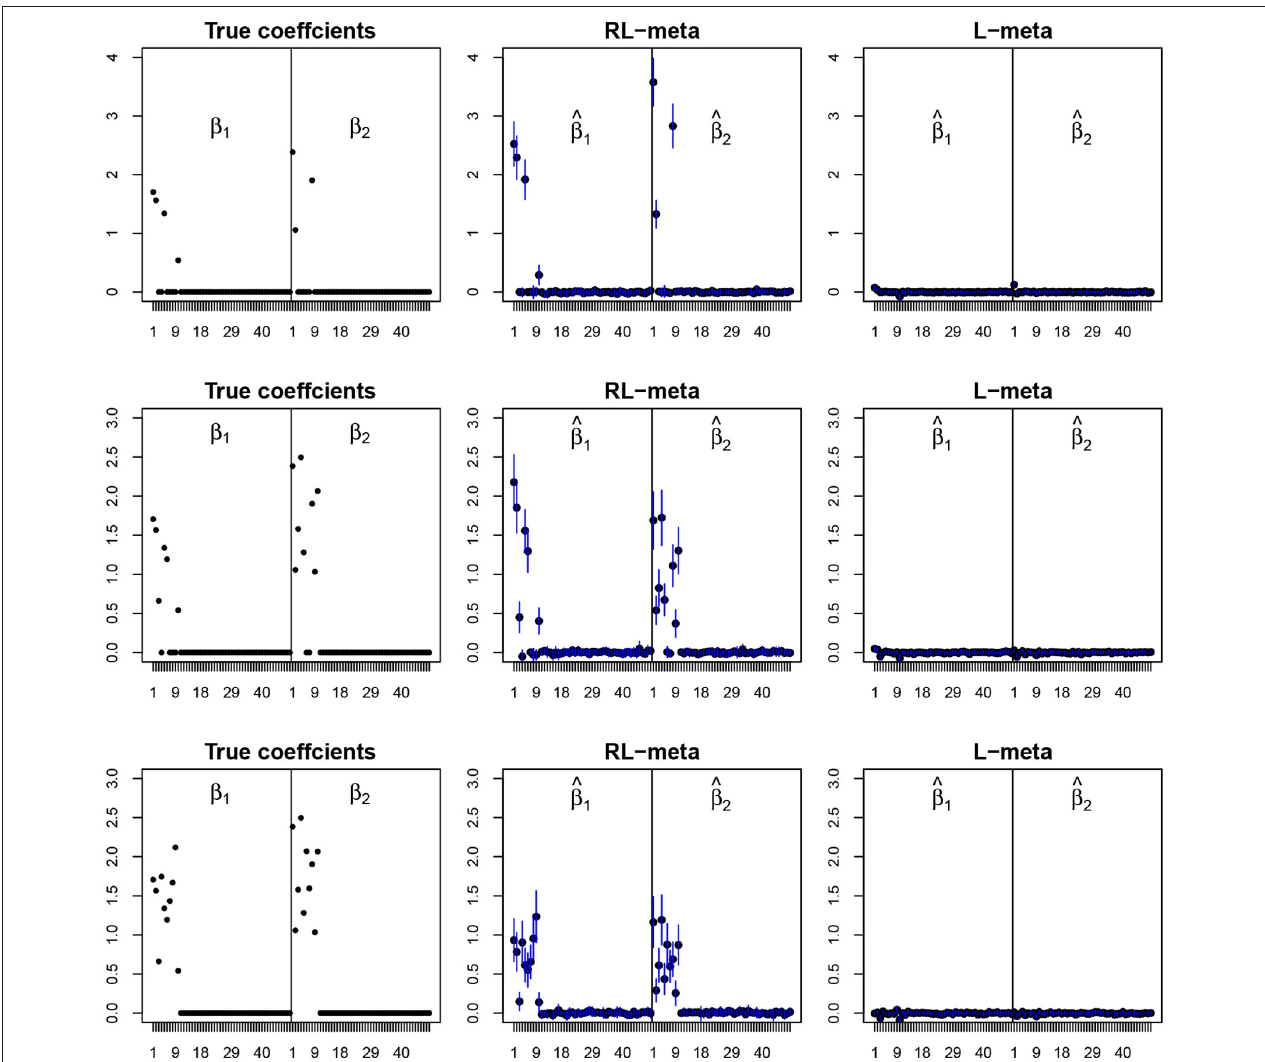
FIGURE 4 | The coefficient estimates with contamination data for M = 2 and ( n , p ) = (100,50). The blue points and lines represent the mean values and the interval estimates of coefficients over 100 simulations. Rows from top to bottom correspond to π 0 = 0.2,0.5,0.9, respectively.